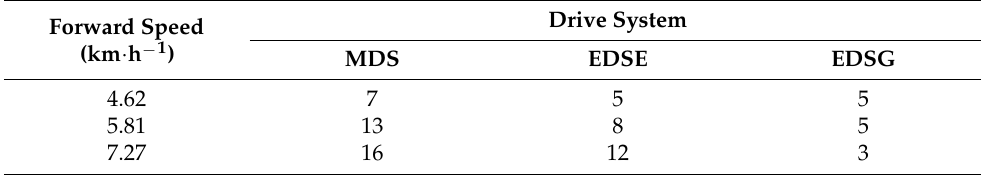
Table 1. The number of broken strips for six rows of the direct seeder under the three driving systems (there were 180 measuring strips in total for each treatment).